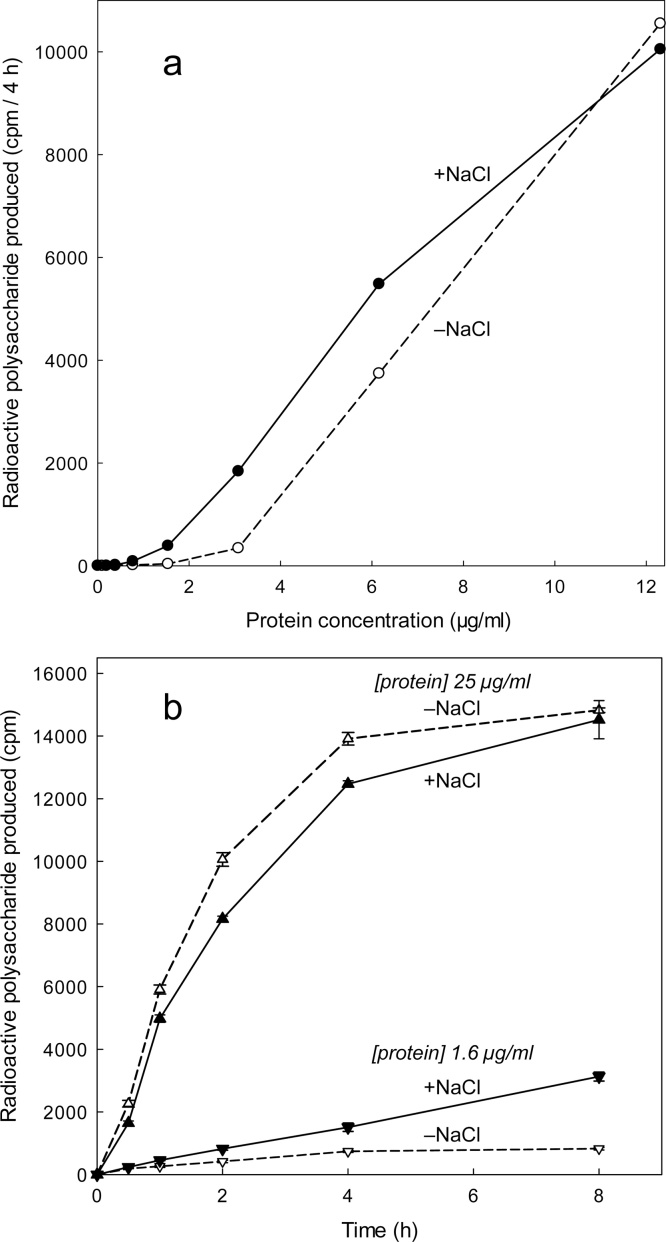
Non-linear relationship between XTH24 concentration and measurable XET activity. (a) The stock AtXTH24 solution was serially diluted in water (in polypropylene Eppendorf vials). The enzyme solution was then assayed for XET activity, in the same vials, in the presence and absence of 240 mM NaCl. (b) Time-course of XET action exhibited by two dilutions of stock XTH24 (protein concentration 2.1 and 25 μg/ml) in the presence and absence of 240 mM NaCl. This experiment was conducted twice, with similar results; one run is shown. In these experiments, the volume sampled had contained 1.0 kBq [3H]XXXGol (carrier-free); the theoretical maximum yield of polysaccharide product was about 17,000 cpm.